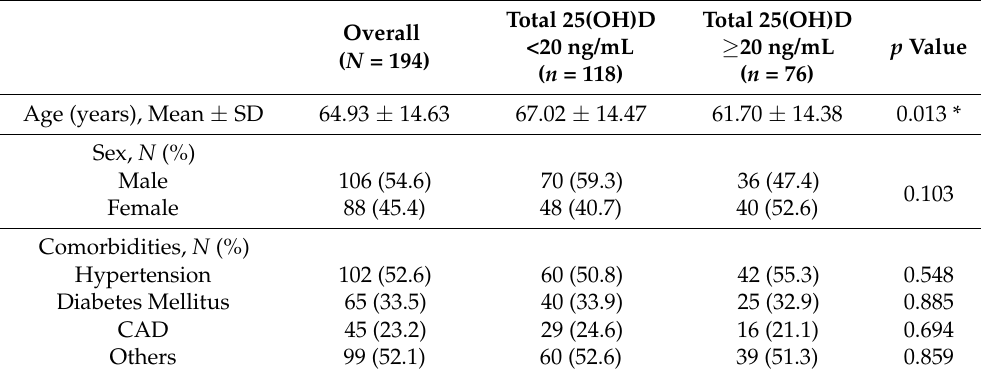
Table 1. Demographical features of COVID-19 patients compared according to the vitamin D status.